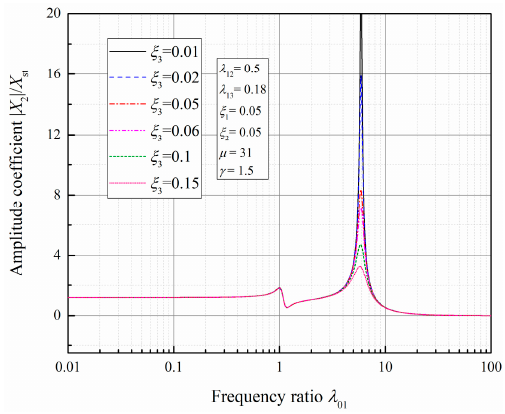
Figure 15. The dynamic response of the accessory structure upon varying the parameter ξ 3 .